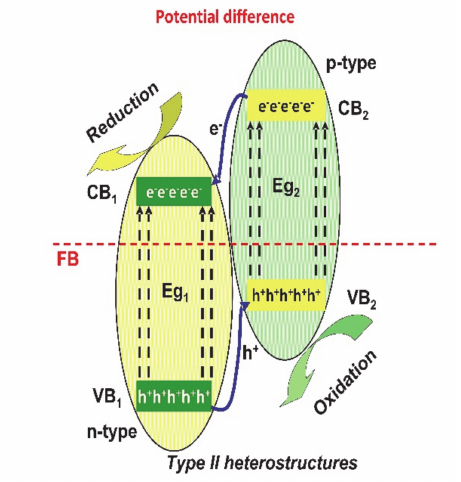
Figure 3. The type-II heterostructures